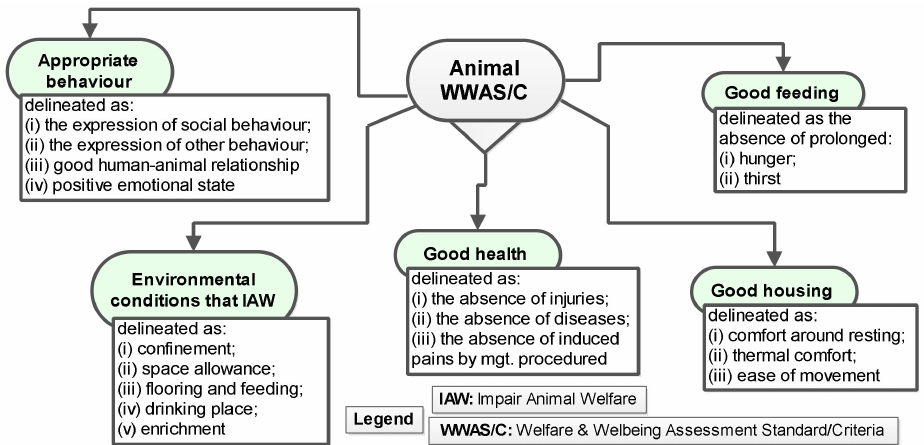
Figure 7. Standard principles for assessing animal